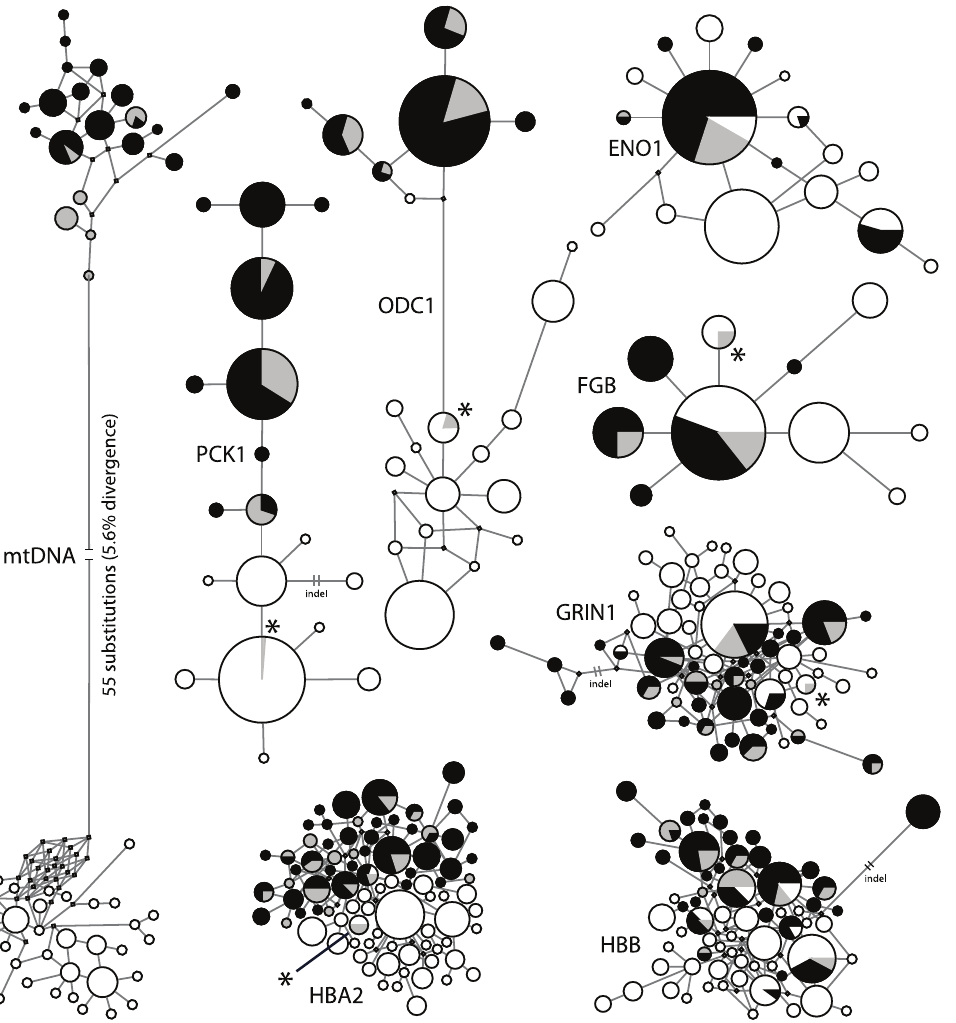
Figure 3. Networks for eight genetic loci. Speckled teal alleles are illustrated in black (Argentina) and grey (Falkland Islands), and yellow-billed pintail alleles are illustrated in white. Circle area is proportional to the number of shared alleles. Asterisks indicate the positions of putatively introgressed yellow-billed pintail alleles for two individuals (REW 325 and REW 325) in the Falkland Islands. doi:10.1371/journal.pone.0023173.g003 PLoS ONE |